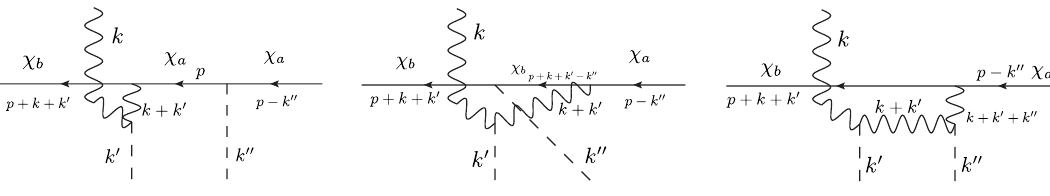
Figure 12 . Treat the k + k 0 line as a new \external" line recursively when it has a vector neighbour.